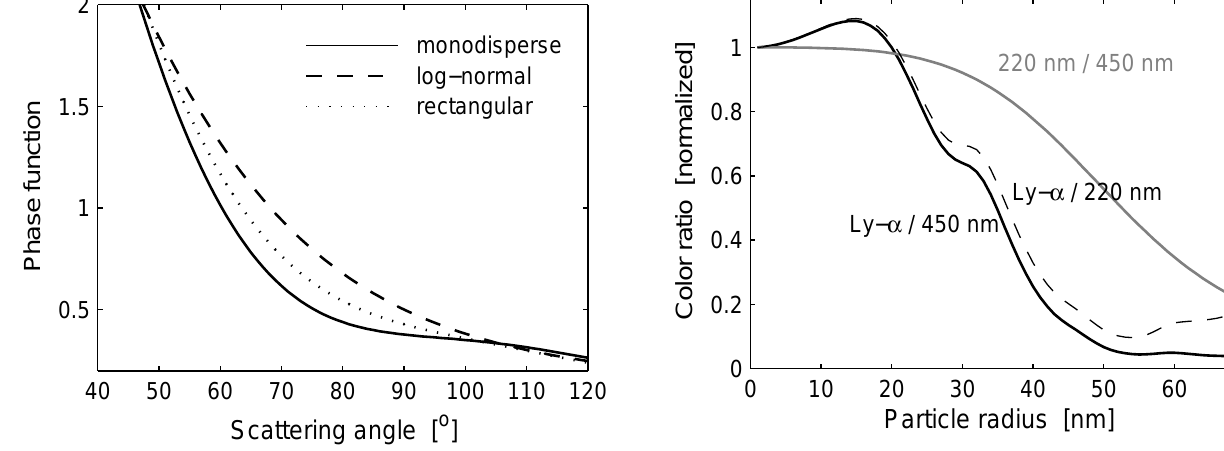
Fig. 5. Phase functions corresponding to the particle populations in Fig. 4, now calculated for Lyman- α . By studying the phase func- tions at 222nm and Lyman- α , the ambiguity in the optical analysis is removed.